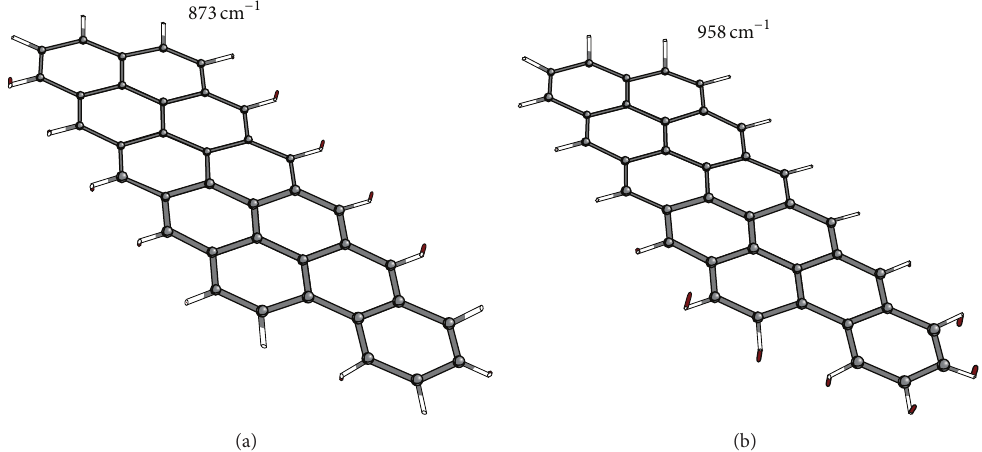
Figure 3: Calculated INS vibrational modes for Model 1 in region (ii). Carbon atoms are grey, hydrogen atoms white, and displacement vectors red arrows. The contribution at 873 cm −1 is clearly connected to an in-phase oscillation of solo species on well-extended borders, while the intense mode at 958 cm −1 is connected to out-of-phase modes at duo , trio , and quatro sites that characterize a defective and not extended